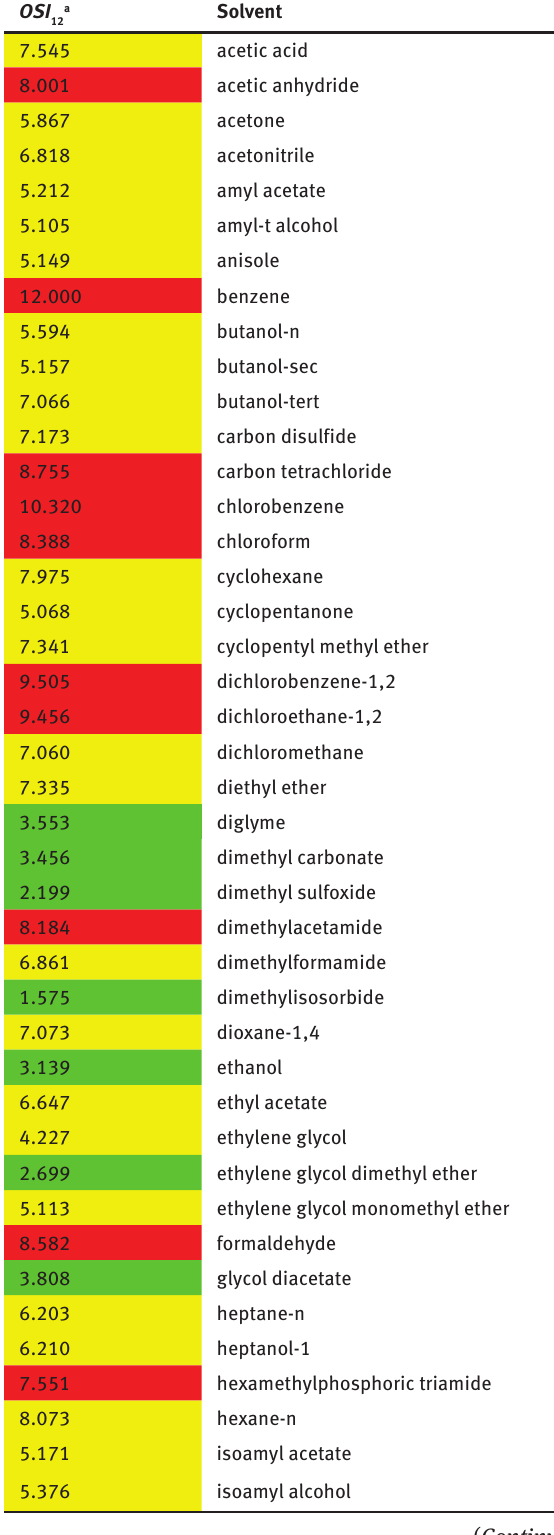
Table 1: Summary of overall solvent index (OSI) for various organic solvents used in the pharmaceutical